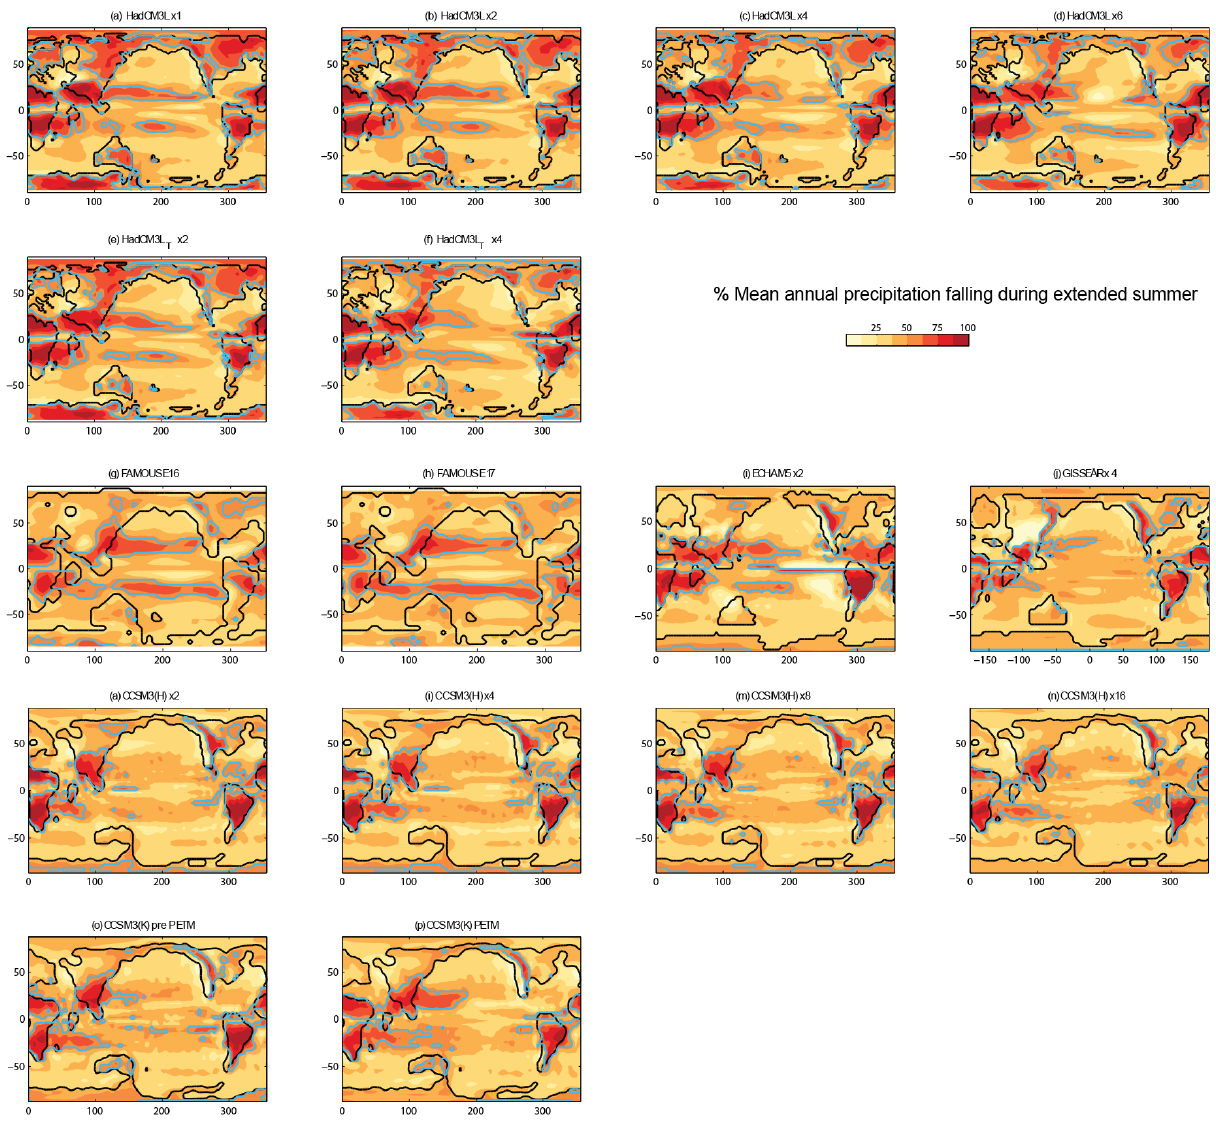
Figure 7. Percentage of mean annual precipitation falling in the extended summer season (MJJAS for Northern Hemisphere, NDJFM for Southern Hemisphere; early Eocene paleogeography); regions with >55% summer precipitation are outlined in blue. Results from preindustrial simulations are shown in the Supplement. CO 2 for each model simulation is shown above each plot. The FAMOUS simulations are both at x2 CO 2